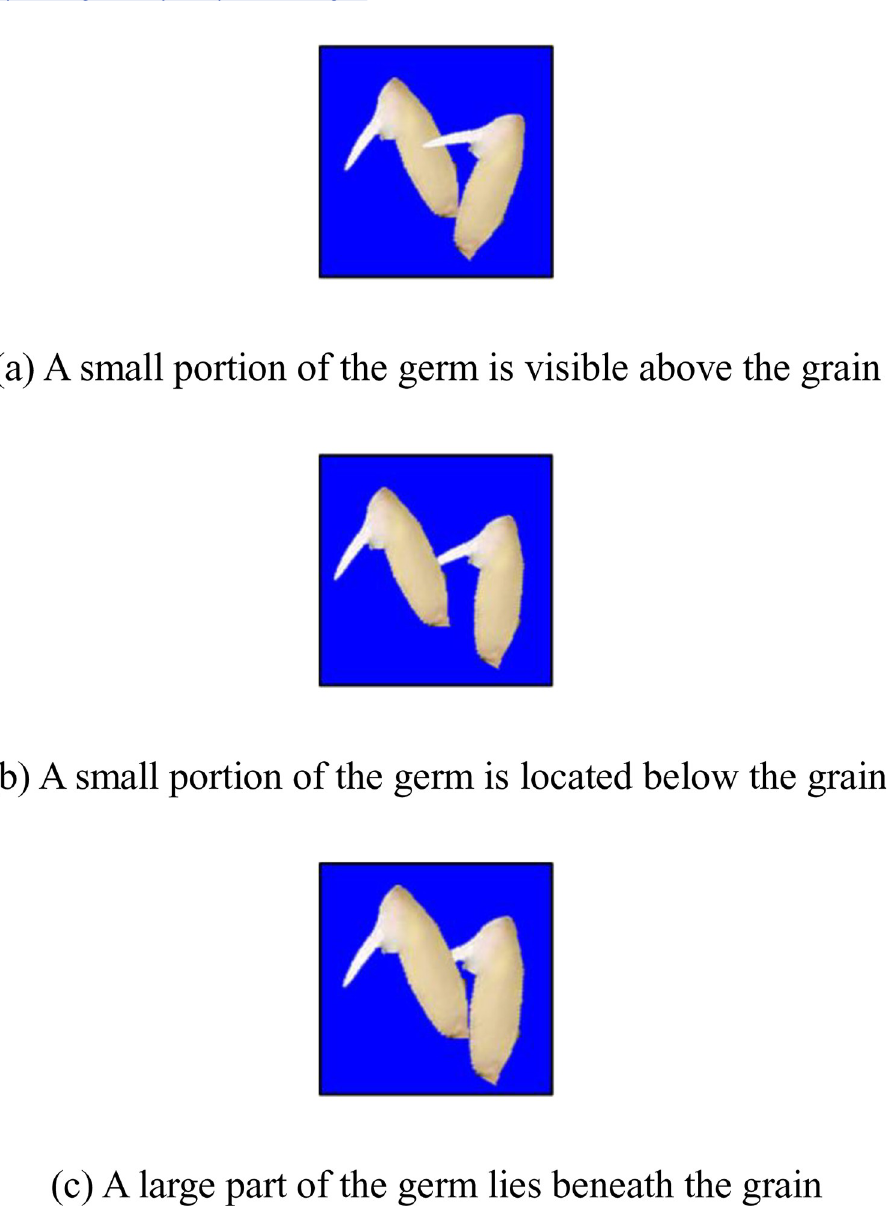
Fig 15. The germ-to-grain